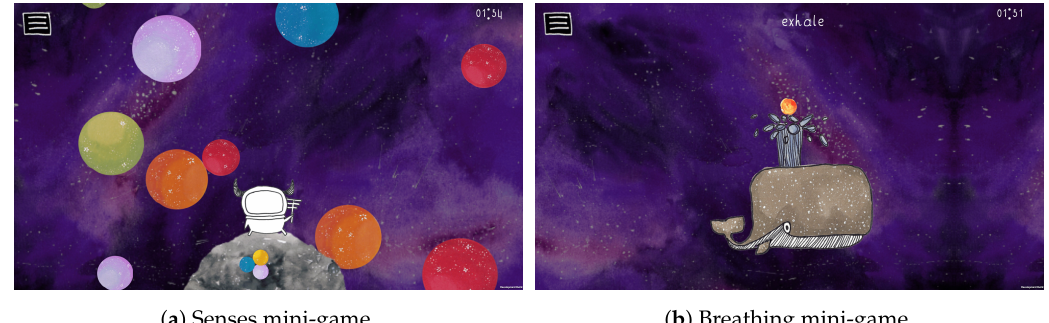
Figure 2. Screenshots from the relaxation module of the New Horizon game. c (cid:13) Stéphanie Carlier.